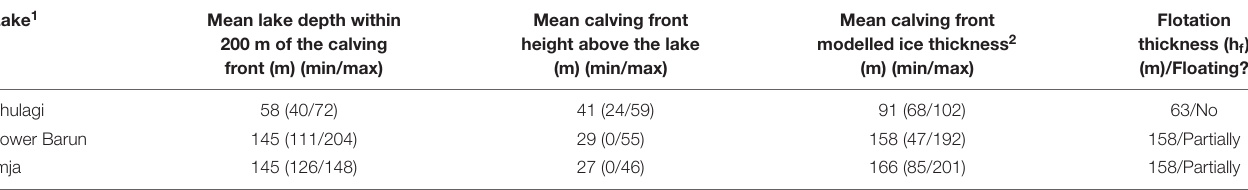
FIGURE 8 | (A) Photograph of Thulagi Glacier terminus from a helicopter flight in May 2013 and (B) the same view from a textured SfM model (27 October 2017). Red dots indicate stable features for image registration. (C) Calving front and ice ledge in September 2013 (see also Supplementary Figure S3 ). (D) The calving front and portal in October 2017. TABLE 4 | Calving front characteristics that correspond to the lake and calving front zones shown in Supplementary Figure S2 . Lake